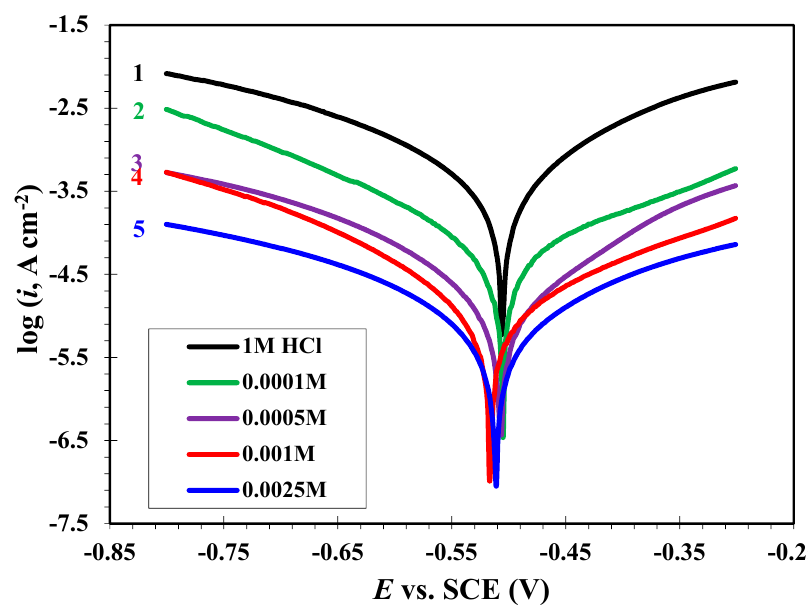
Figure 5. Anodic and cathodic polarization curves for MS obtained at 20 °C in 1 M HCl solution in the absence and presence of different concentrations of CGSES14.